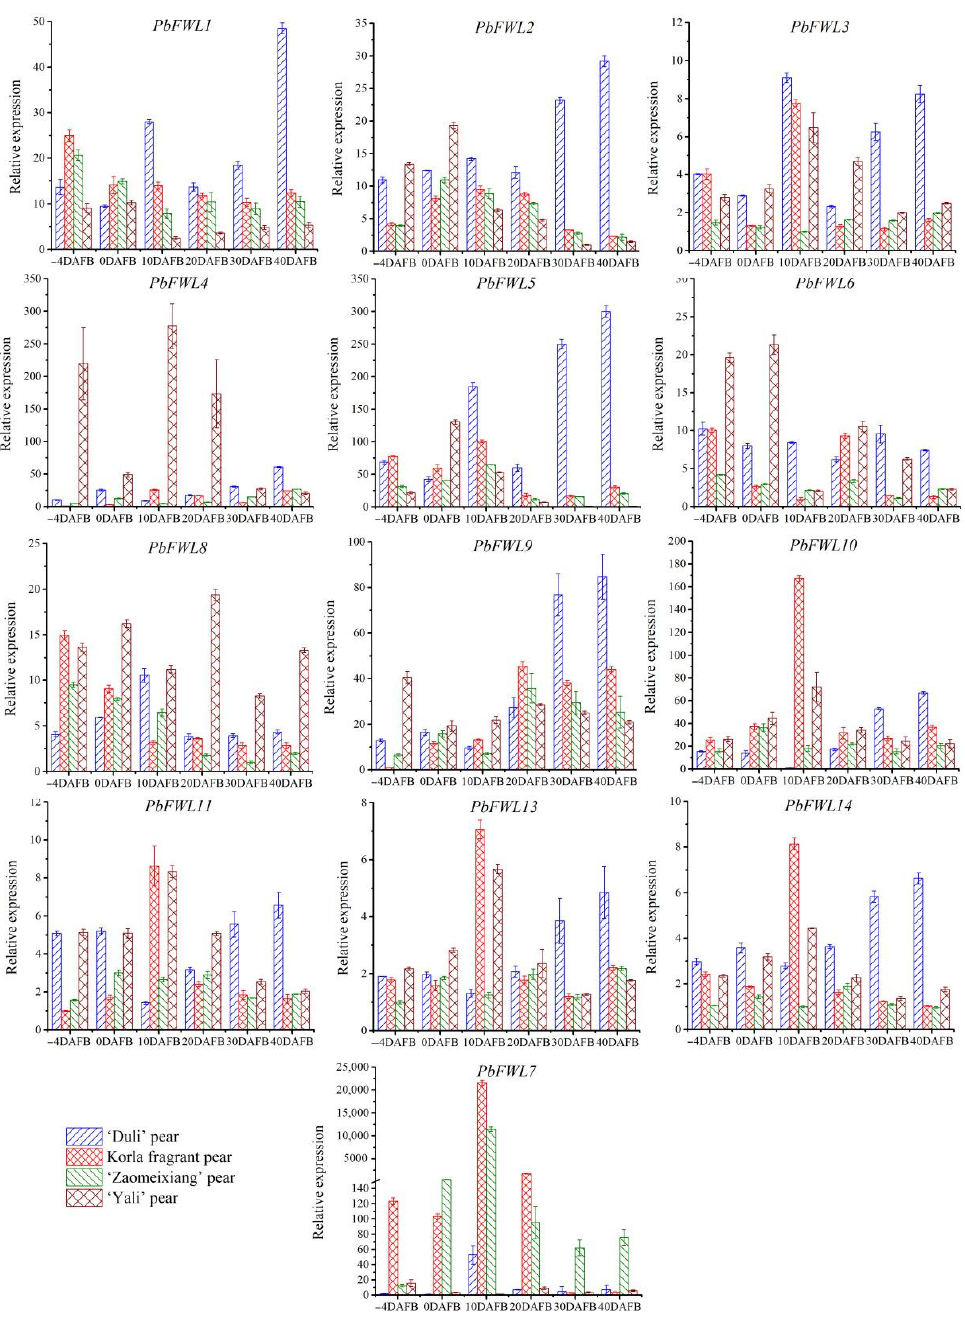
Figure 7. Relative expression levels of PbFWL genes in ‘Duli’ pear, Korla fragrant pear, ‘Zaomeixiang’ pear, and ‘Yali’ pear flower bud and fruit development. The vertical bars represent the standard error of triplicate experiments.